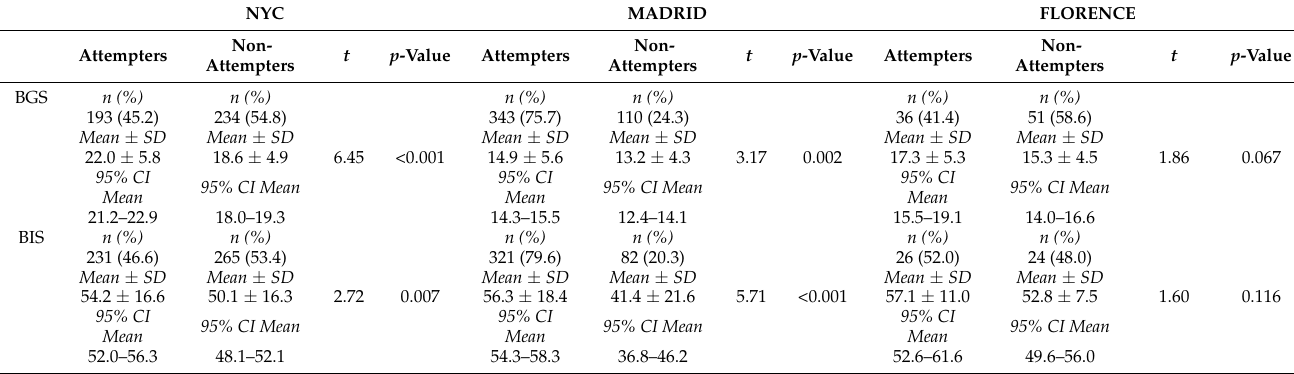
Table 3. Differences in BGS and BIS total scores between suicide attempters and non-attempters across